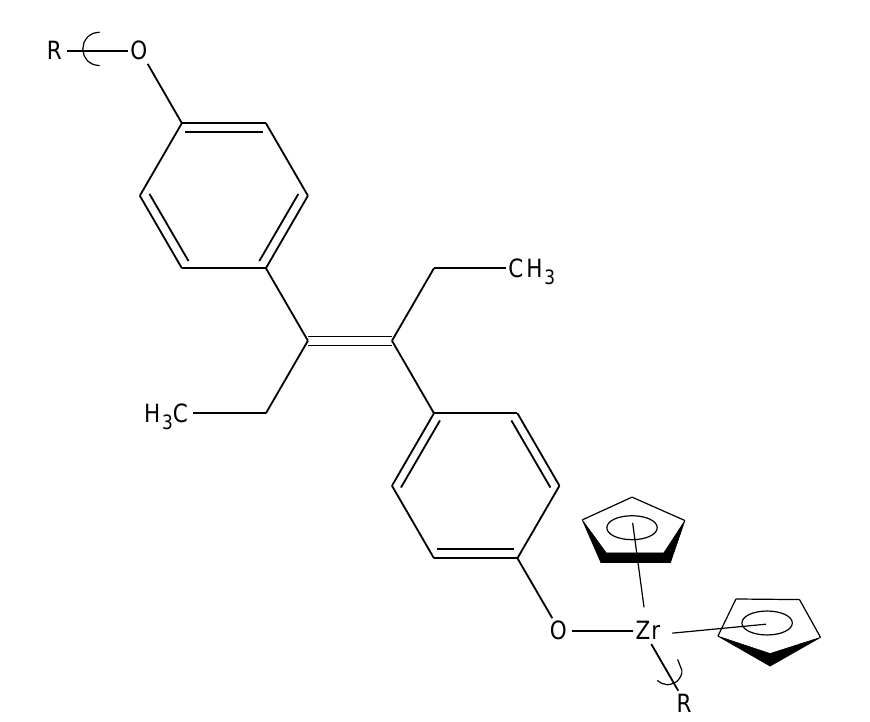
Figure 7. Repeat unit for the product of bis(cyclopentadienyl)zirconium dichloride and diethylstilbestrol.